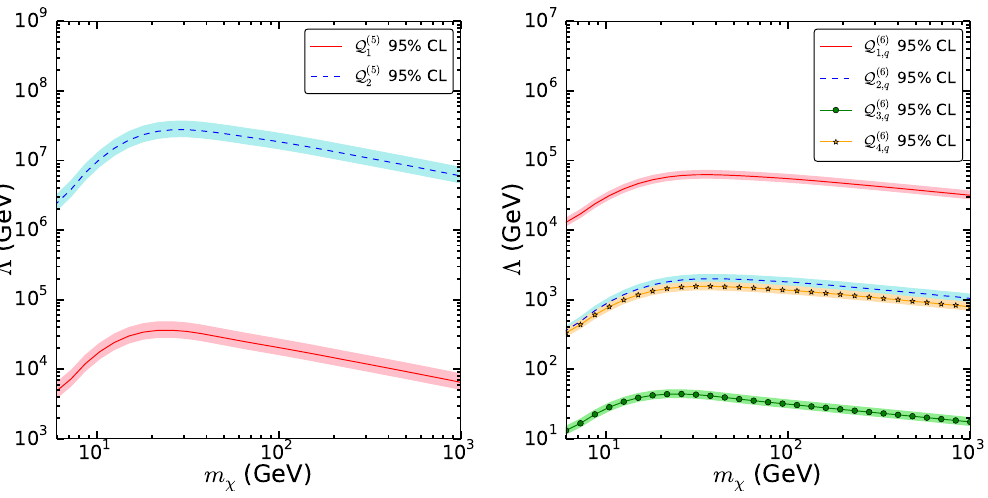
Figure 10 . The 95% CL lower limits of the energy scale (cid:3) for dimension-(cid:12)ve (left) and dimension- six (right) DM-quark interactions. The color bands demonstrate the uncertainties of the local DM density measurements